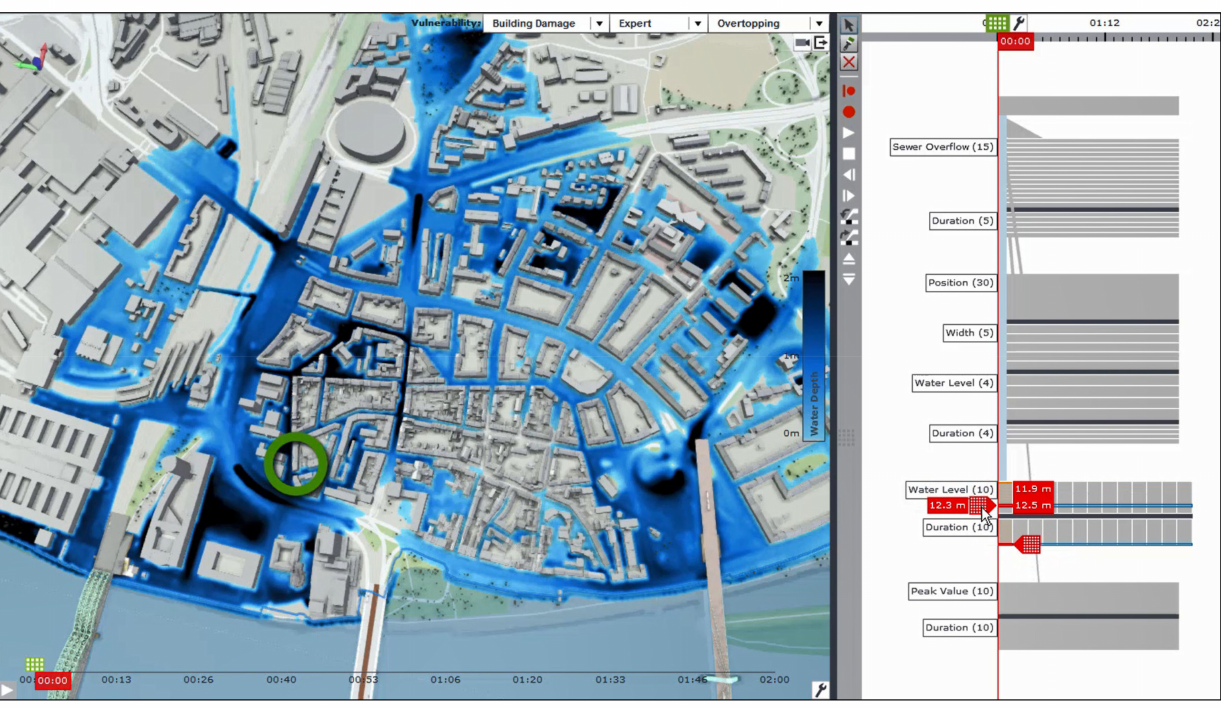
Figure 13. Selection of different floodwall overtopping scenario from the parameter-based and time- based world lines (green circle marks the building of interest). In this illustration, a water level of 12.3 m was selected and the resulting flooding scenario visualized for selected overtopping